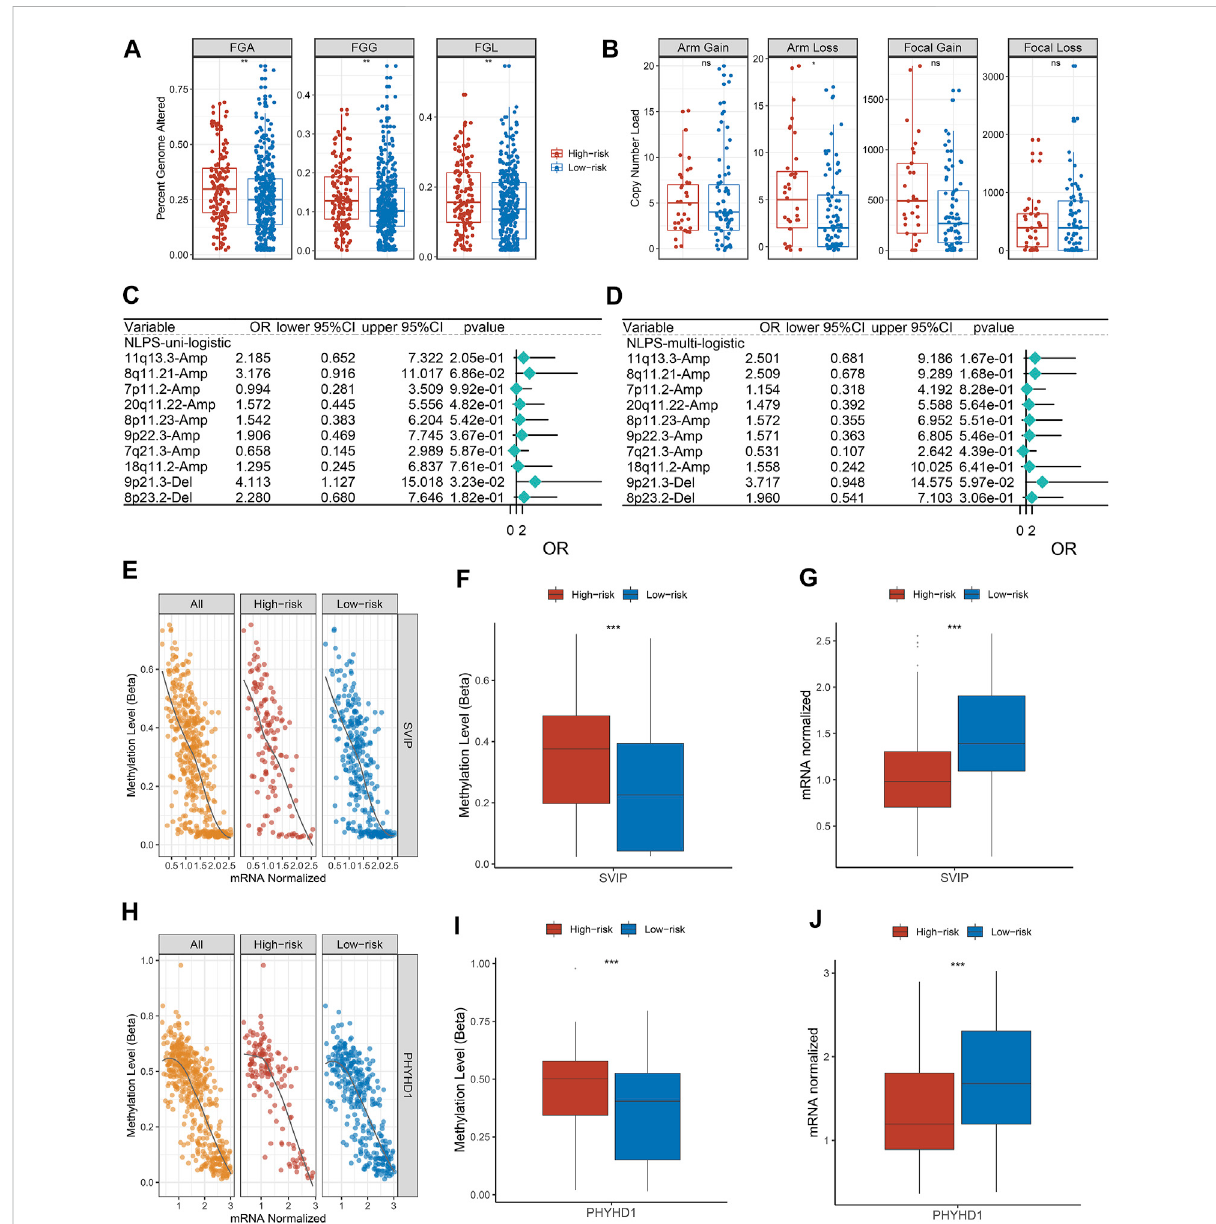
FIGURE 7 Copy number variation and methylation-driven genes. (A) Distributions of a fraction of genome alteration, gain and lost between two groups. (B) Distributions of arm gain, arm loss, focal gain, and focal loss. (E,H) Correlation between gene expression and methylation of SVIP (E) and PHYHD1 (H) . (F,G) The differences of SVIP methylation (F) and mRNA expression (G) . (I,J) The differences of SVIP methylation (I) and mRNA expression (J) . * p < 0.05, ** p < 0.01, *** p < 0.001, **** p <